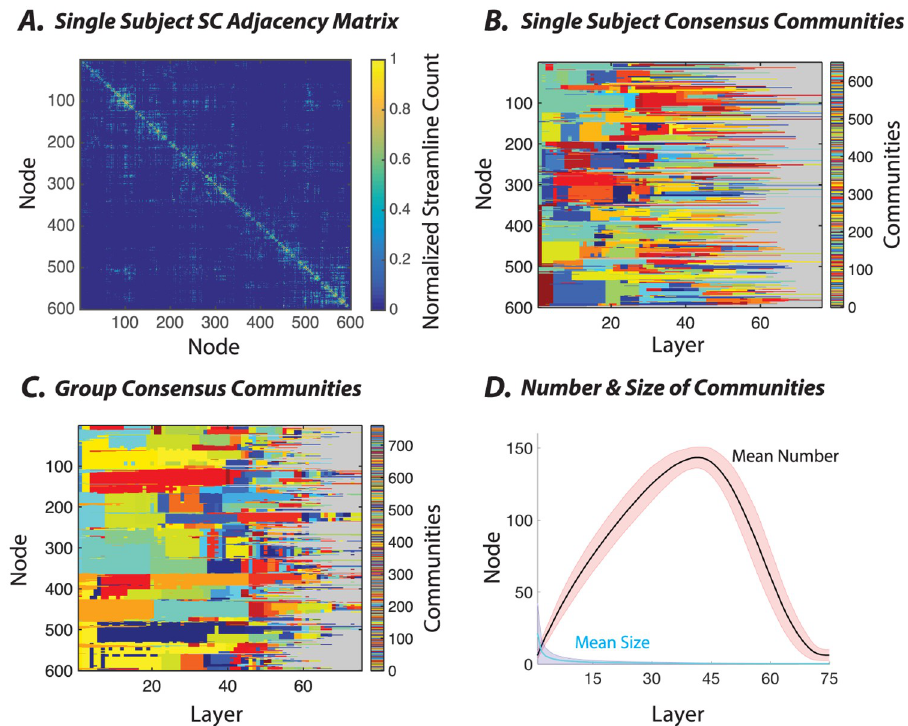
Fig 3. Application of multi-scale community detection to subject-level and group-level structural brain networks. (A) An example structural connectivity matrix from one subject, in which each element linking a pair of brain regions represents the number of streamlines reconstructed between those two areas. To better visualize its structure, we apply a log transformation (log( SC + 1)/max(log( SC + 1))). (B) The consensus partition representing the multi-scale community structure for the matrix in panel (A) . To enhance the visual detection of communities, we have represented all singleton communities with the same gray color. (C) The group-level consensus partition representing the multi- scale community structure for the structural matrix, which is defined as the consensus over all participants’ partitions. Here, again, to enhance visual clarity, we color the singleton communities in the same gray color. (D) The average number (out of 600 total nodes) as well as the average size (expressed as the percentage of total nodes) of the non- singleton communities calculated across layers, which in our case represent γ increments. In these analyses, we used γ 2 [0.0133, 1], an inter-layer γ increment of 0.0133, and 75